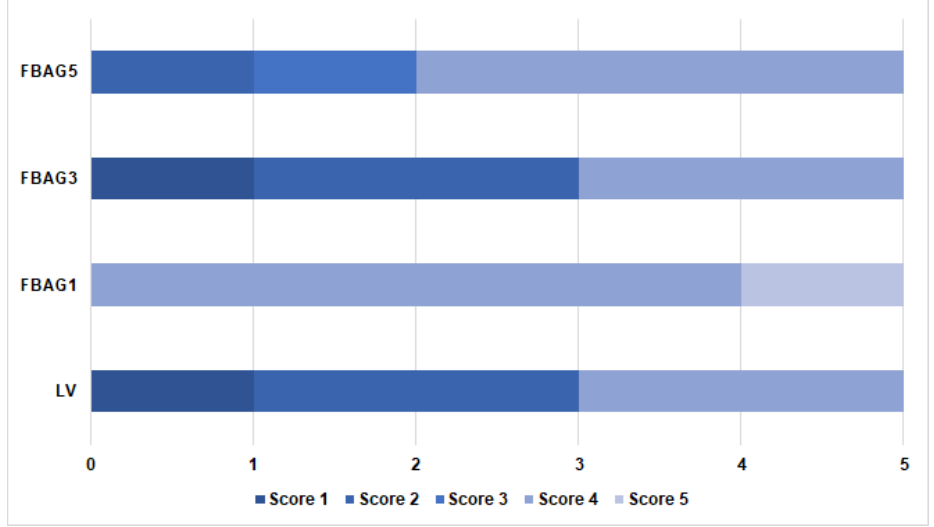
Figure 6. ARI scores for evaluated orthodontic bonding adhesives. The ARI score was not significantly di ff erent according to the Kruskal-Wallis test at α = 0.05 (n = 5).